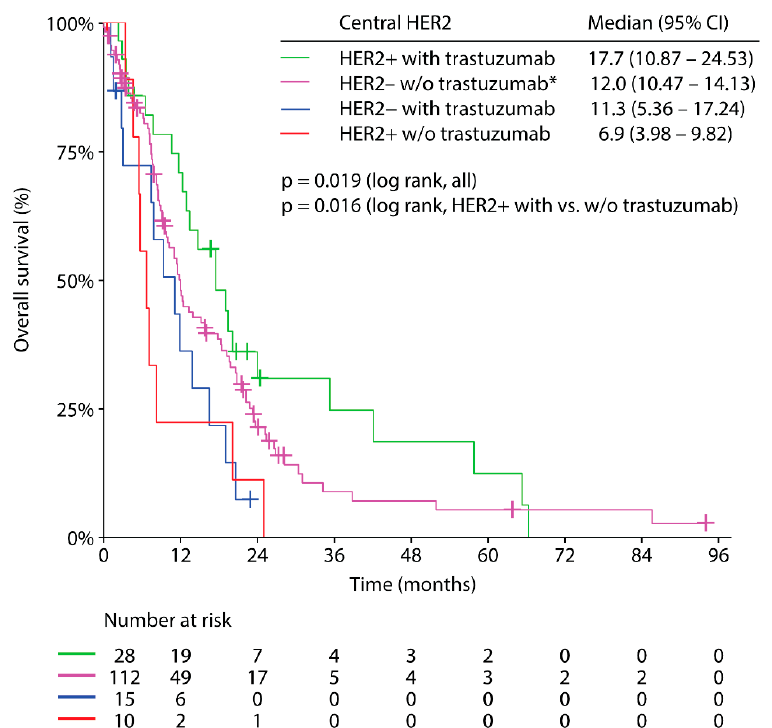
Figure 4. Overall survival from diagnosis of metastatic gastric / GEJ cancer according to central HER2 status and according to trastuzumab front-line treatment status. The tick marks on the curves represents censored patients. * According to standard of care.